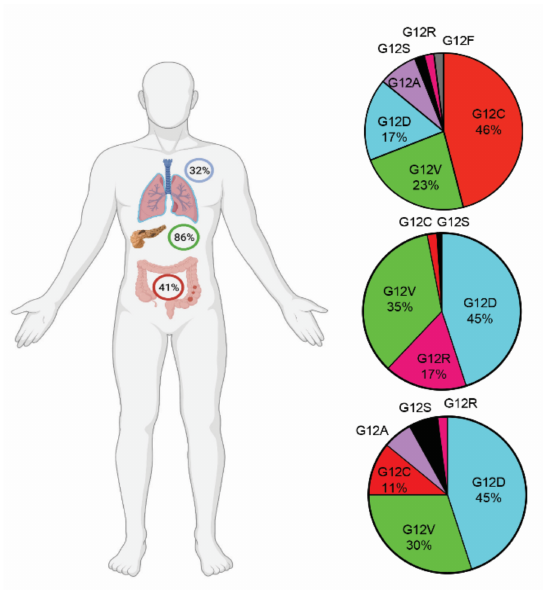
Figure 1. KRAS-G12 substitutions in lung ( top ), pancreatic ( middle ), and colon ( bottom ) cancers. Data are based on patient cohorts in